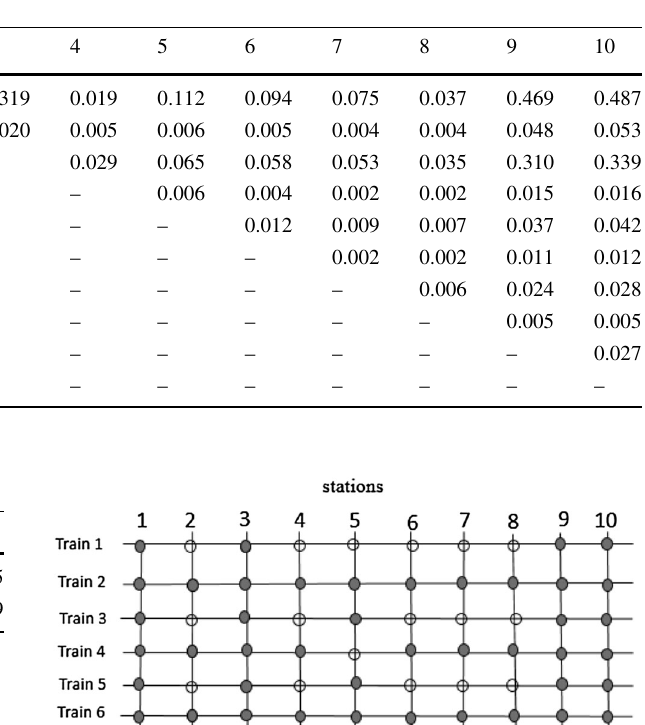
Table 4 The arrival time of passengers with different origins and destinations (passengers per second)